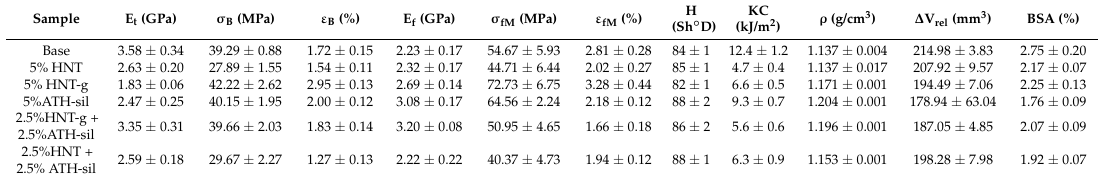
Figure 4. Representative stress–strain curves for the series polymer nanocomposites recorded during static tensile test ( a ) and static bending test ( b ); comparison of the values of elastic and flexural moduli ( c ) and stress at break and flexural strength ( d ) for polymer nanocomposites in relation to the base material. Table 2. The selected physical properties of the base material (MM/mMM) and composites containing modified and unmodified